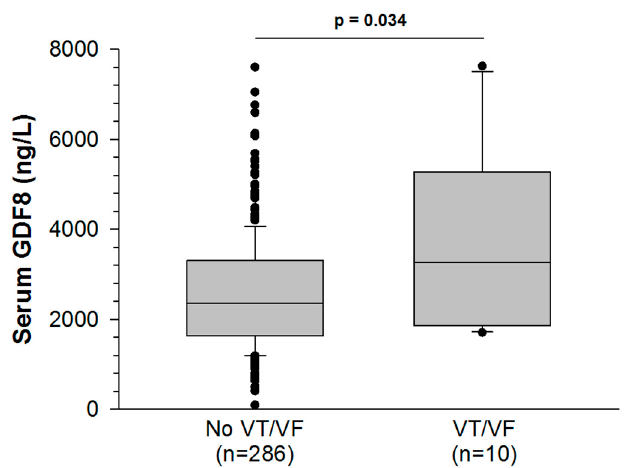
Figure 1. Serum growth differentiation factor-8 (GDF8) levels rise more in AMI patients with ventricular tachycardia or fibrillation (VT/VF) than AMI patients without VT/VF.